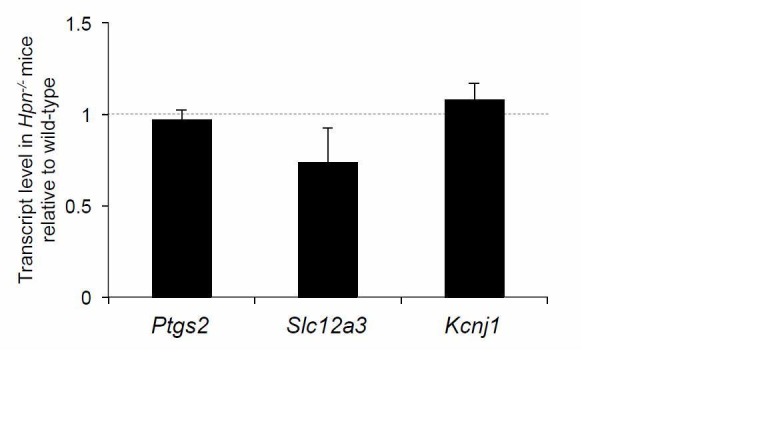
Expression level of renal genes in Hpn-/- mice.Quantification by Real-time qPCR of the mRNA levels of cyclooxygenase 2 (Cox2) (Ptgs2), sodium-chloride co-transporter (NCC) (Slc12a3) and the renal outer medullary potassium channel (ROMK) (Kcjn1) in kidneys of Hpn-/-mice relative to age- and sex- matched wild-type controls (n = 3/group). Bars indicate average ratio ± s.e.m.